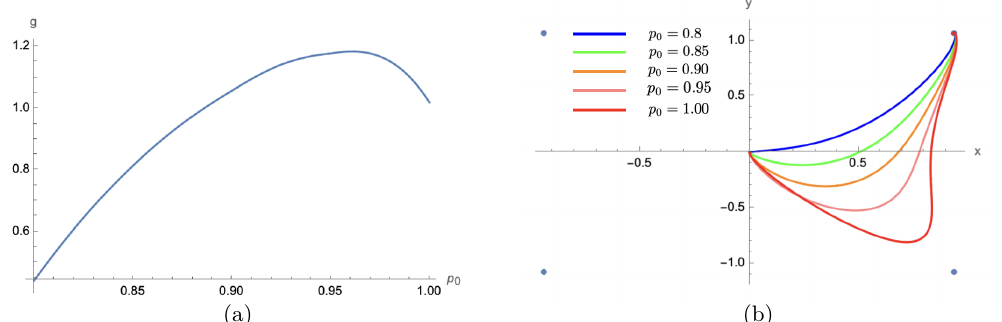
Figure 7. (a) Plot of boundary entropy for RG-flow interface for truncation 2, as a function of initial condition p at the turning point for α = 1 . 4 . (b) Illustration of RG-flows for some initial 0 values of p 0